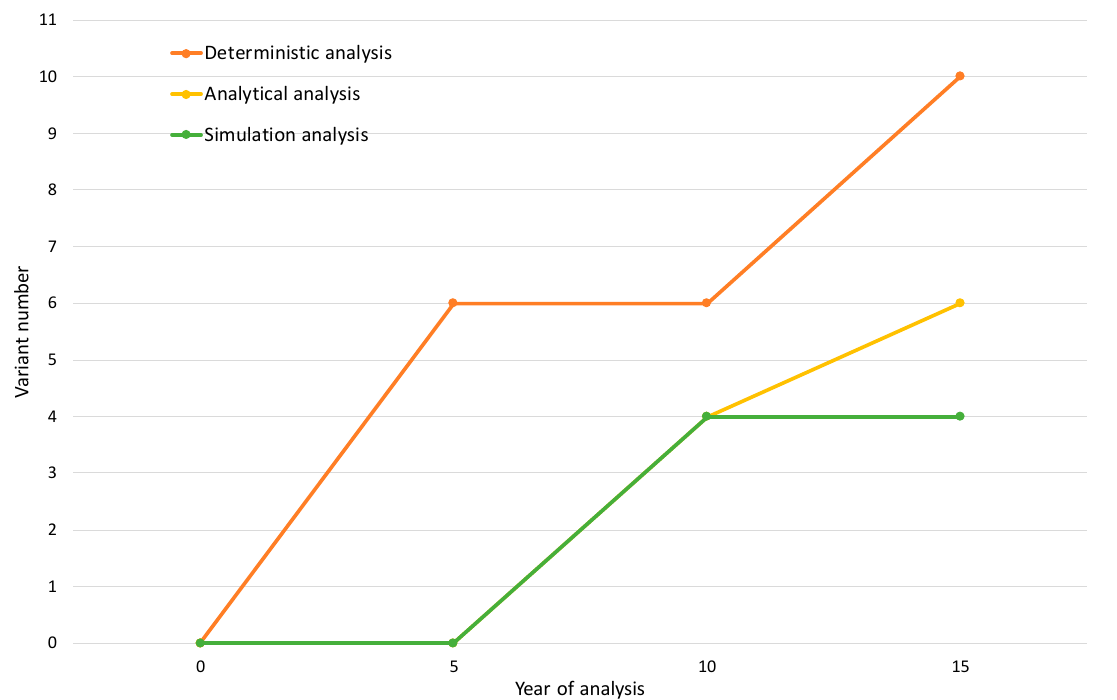
Figure 7. Transmission network development strategies obtained in the model study process.